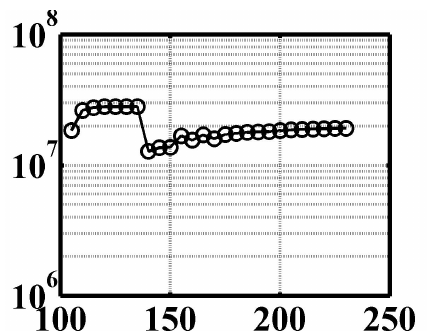
Fig. 5. Fig. 5. Predictions of the expected total (event-integrated) FEP flu- ency for E k ≥ E o = 0 . 1 GeV . The ordinate axis is the total FEP flu- ency (in cm − 2 sr − 1 ) , and the abscissa is time when the prediction was made, in minutes from 10:00 UT on 29 September